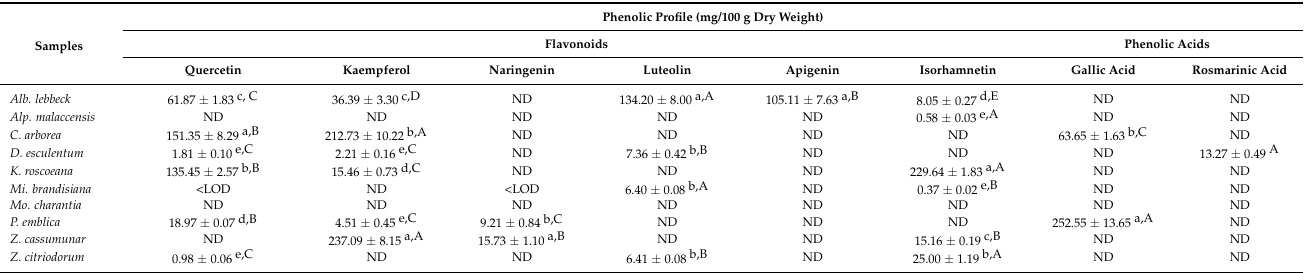
Table 1. Phenolic profiles of 10 indigenous plant extracts determined using liquid chromatography- electrospray ionization tandem mass spectrometry